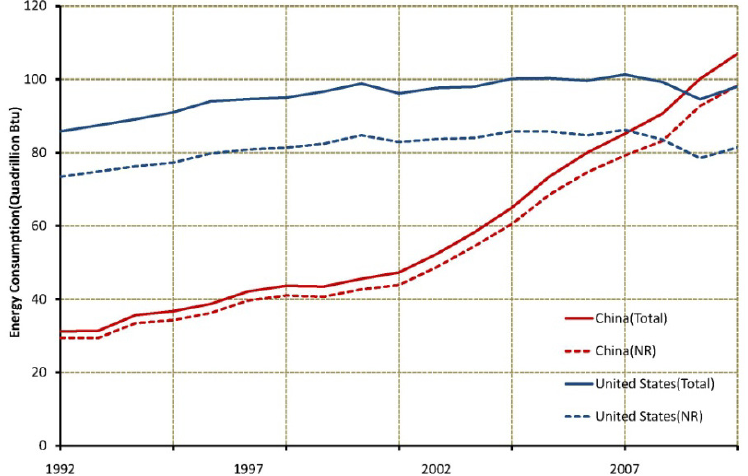
Figure 3. Temporal trends of energy consumption from 1980 to 2010 in China (NR: non-renewable resources, data of energy consumption are provided by EIA. This figure shows temporal trends and differences of energy consumption in America and China from 1992 to